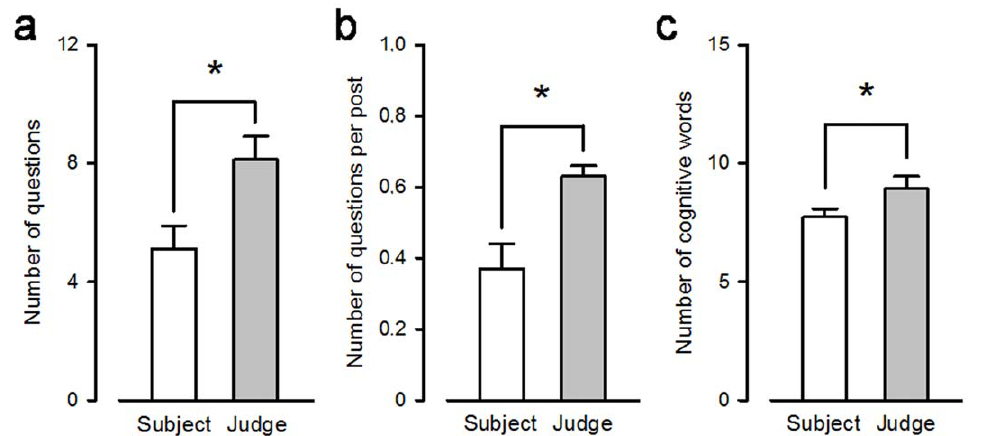
Figure 4. Indicators of interest. (a) The number of questions, (b) questions per post and (c) cognitive words the subjects and the judges have displayed when the subjects were perceived as humans, p , .05 (Student paired